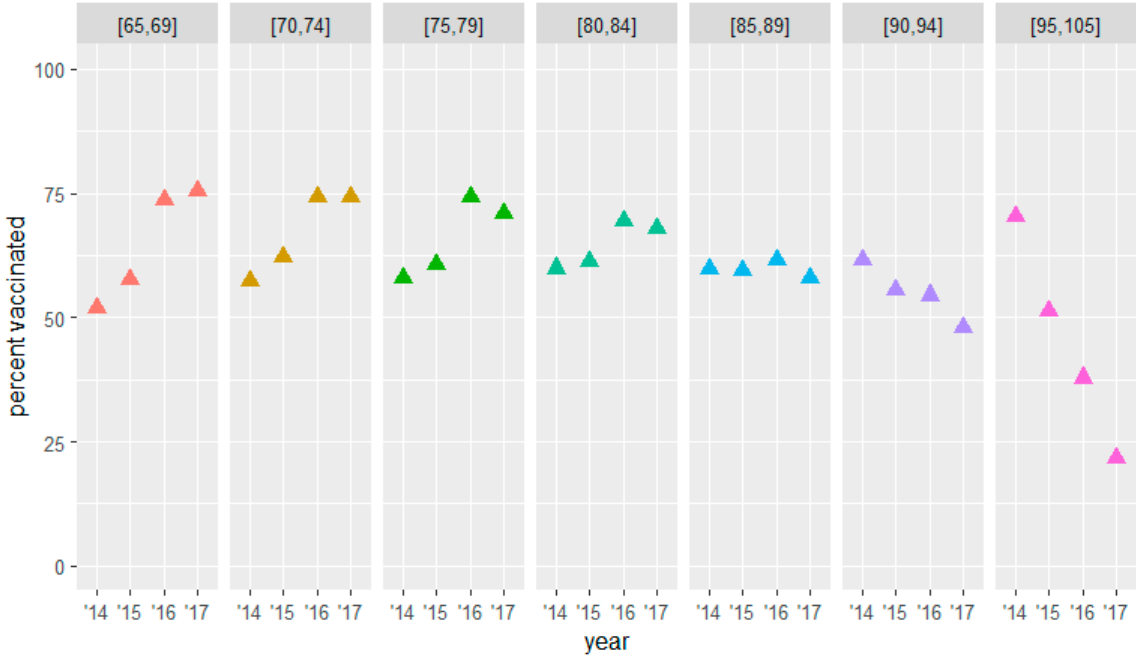
Figure 2. Influenza vaccination uptake by age at baseline ≥ 65 group (with chronic condition).